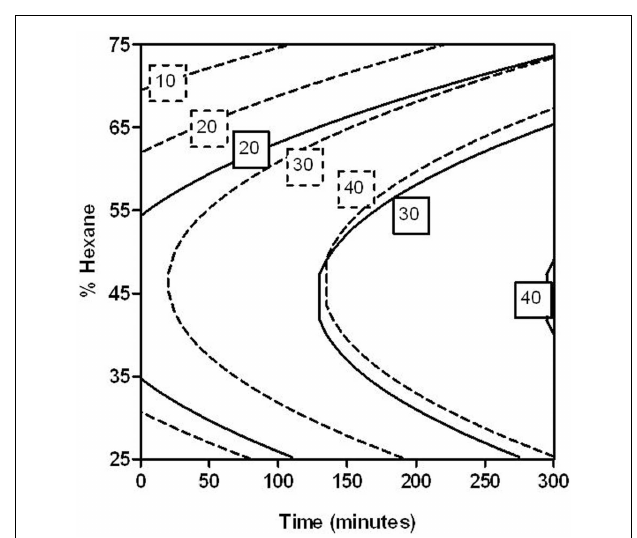
FIGURE 5 | Combination of percentage of hexane (25–75%) and extraction time (0–300min) to obtain different carotenoid extraction yields (CEYs) from control (solid lines) and PEF-treated (dotted lines) tomato peels .